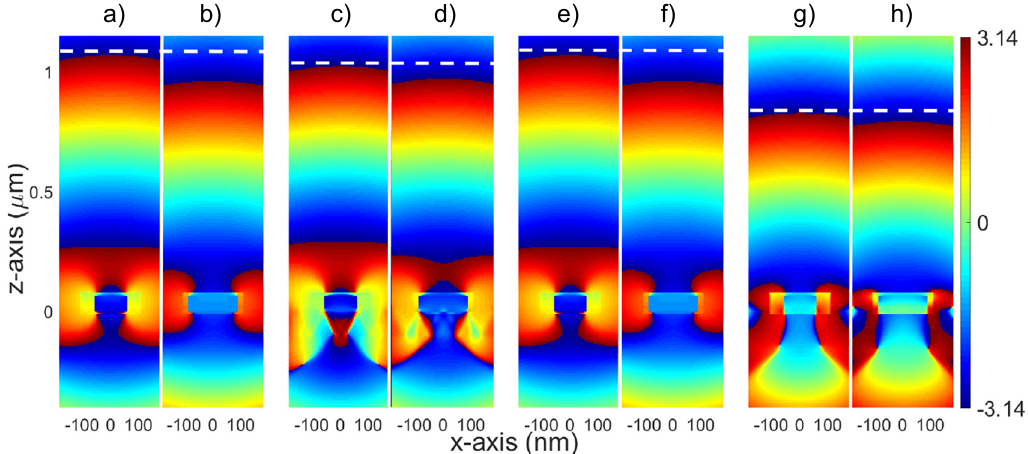
Figure 4: Phase profiles (in the unit of radian) of x component of the scattered E- fi eld up to 2 λ from the NDs of diameters (a) 120 nm and (b) 180 nm on glass at λ = 684 nm and (c) 120 nm and (d) 180 nm on HMM-1 at 684 nm. Similarly, (e) 120 nm and (f) 180 nm on glass at λ = 751 nm and (g) 120 nm and (h) 180 nm on HMM-2 at λ = 751 nm. White dotted lines are added for better visual comparison. HMM, hyperbolic metamaterial; ND,